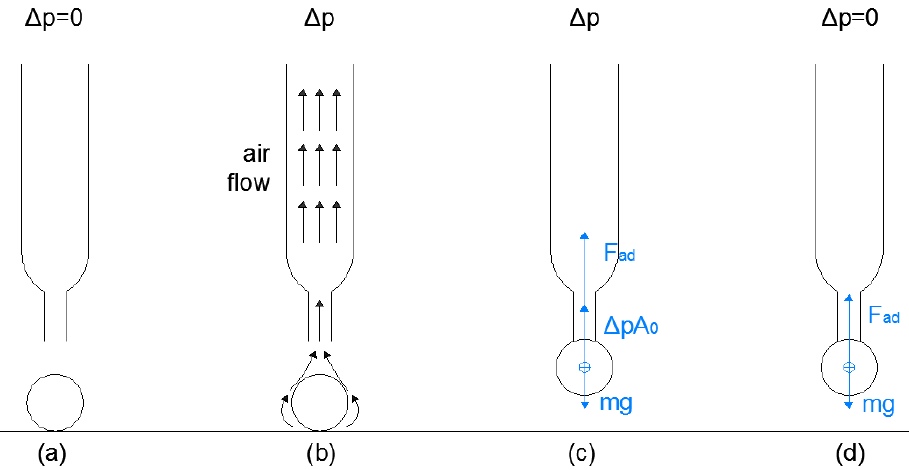
Figure 1. Off ( a ), grasping ( b ), handling ( c ) and releasing ( d ) manipulation phases of a classic vacuum